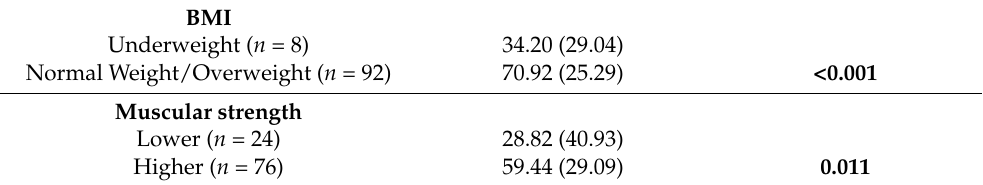
Table 3. New device showed adequate ECC by categories of body mass index and muscular fitness. BMI Underweight ( n = 8) 34.20 (29.04) Normal Weight/Overweight ( n = 92) 70.92